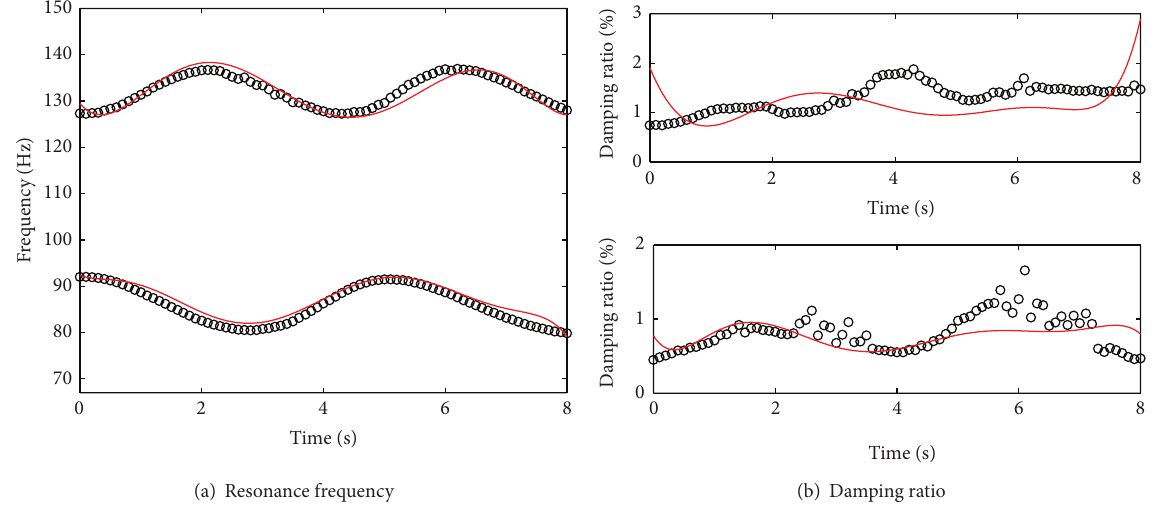
Figure 10: Estimated modal frequency and damping